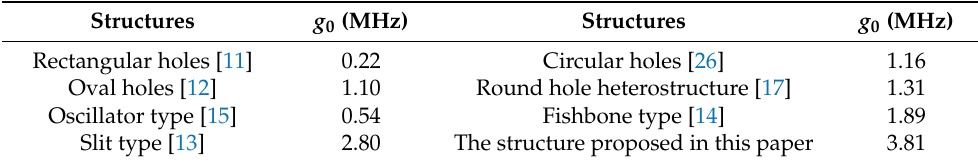
Figure 5. Modal diagrams of the single − mirror and the hetero − optomechanical crystal nanobeam resonators: ( a , b ) the electric field E y component and the displacement field S yy component of the two structures, respectively. Table 3. The optomechanical coupling rate with different